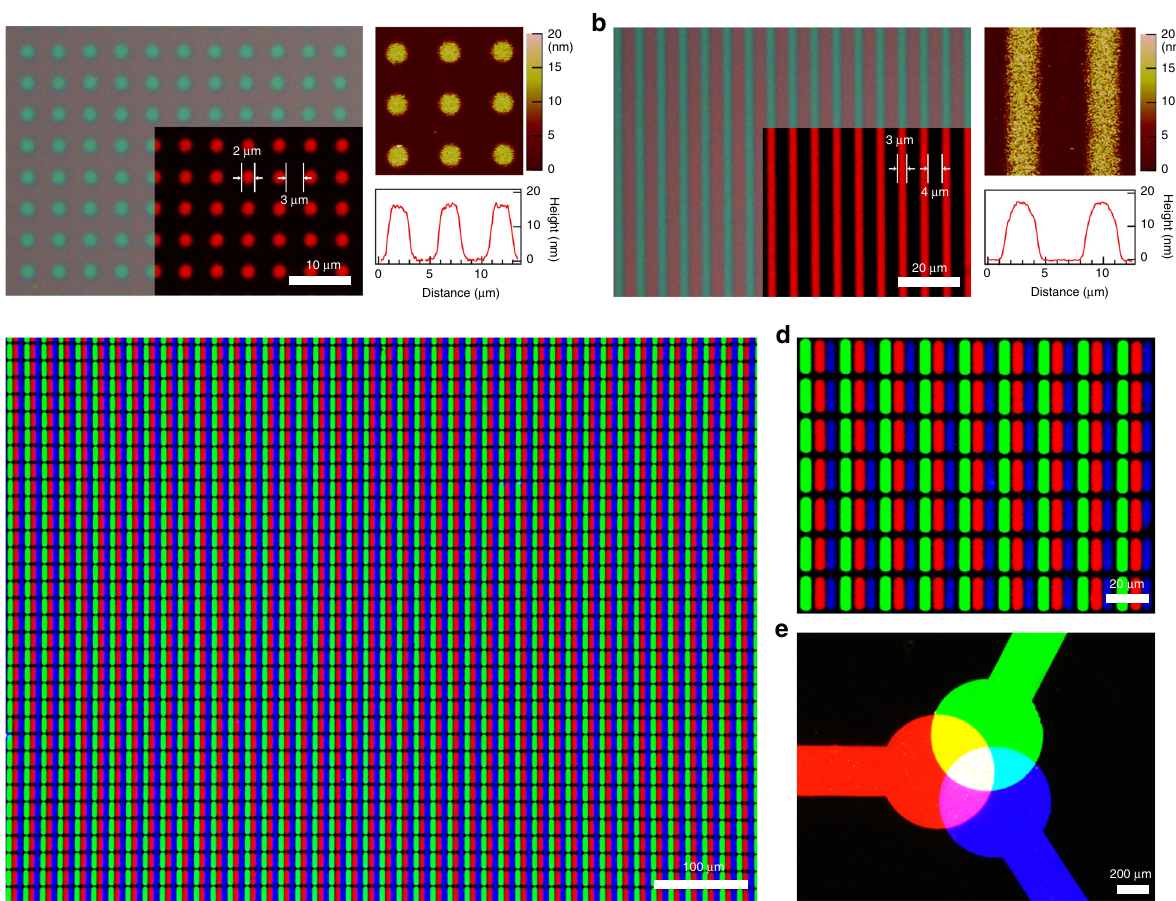
Fig. 3 Optical and fl uorescence images of QD patterns. Optical and fl uorescence (inset) microscopic images and AFM images with height pro fi le of a dot (diameter = 2 μ m, spacing 3 μ m) and b line patterns (width = 3 μ m, spacing 4 μ m) based on 13-nm sized red-emitting CdSe/CdZnS QDs. c – e Fluorescence microscopic images of RGB QD patterns that were obtained through consecutive photo-patterning processes using RGB QDs. The dimension of a sub-pixel in Fig. 3c, d is 4 μ m × 16 μ m, corresponding to a resolution >1400 p.p.i. Fig. 3d is a magni fi ed view of Fig.